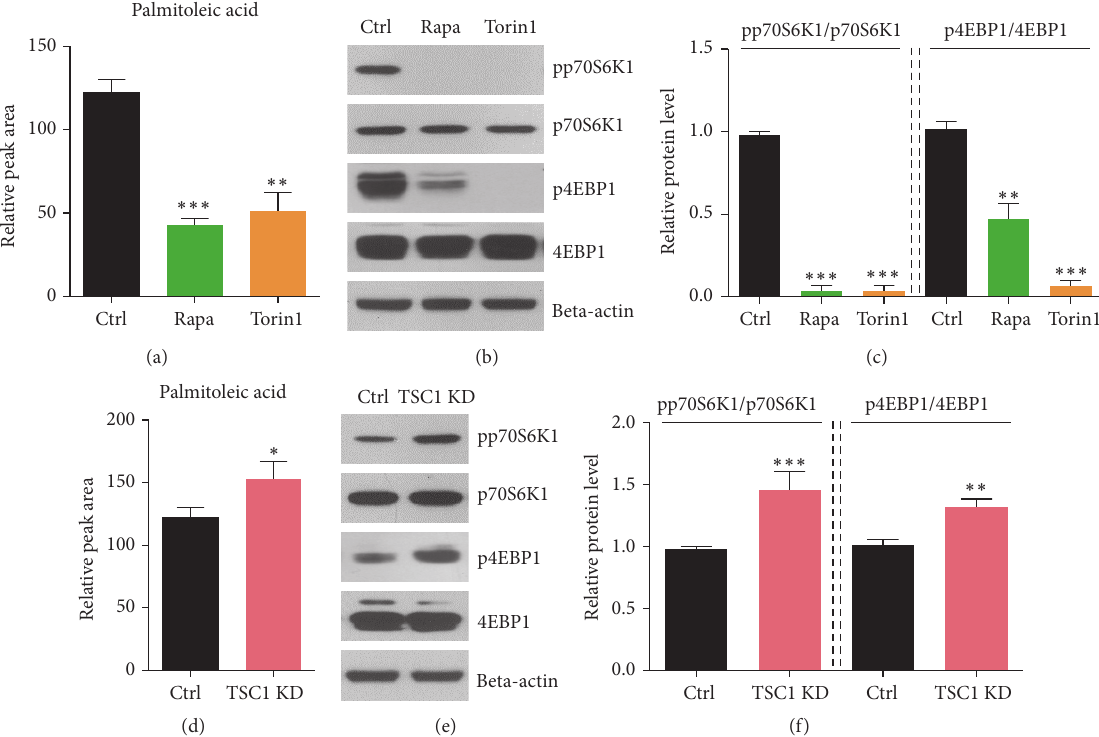
Figure 2: Palmitoleic acid level is positively regulated by mTORC1 signaling. (a) LC-MS results showed the reduction of palmitoleic acid level in both rapamycin (rapa) and Torin1 treated PBMC. Results are averages of five independent experiments. Data represent mean ± SEM. ∗∗ 𝑝 < 0.01 and ∗∗∗ 𝑝 < 0.001 . (b-c) Western blots and quantification showed that mTORC1 activity, indicated by pp70S6K1 and p4EBP1, was dramatically decreased by both rapamycin (rapa) and Torin1 treated cells. Results are averages of three independent experiments. Data represent mean ± SEM. ∗∗ 𝑝 < 0.01 and ∗∗∗ 𝑝 < 0.001 . (d) LC-MS results showed the increasing of palmitoleic acid level in TSC1 knockdown (KD) cells. Results are averages of five independent experiments. Data represent mean ± SEM. ∗ 𝑝 < 0.05 . (e and f) Western blots and quantification showed that mTORC1 activity was dramatically increased by TSC1 KD. Results are averages of three independent experiments. Data represent mean ± SEM. ∗∗ 𝑝 < 0.01 and ∗∗∗ 𝑝 < 0.001